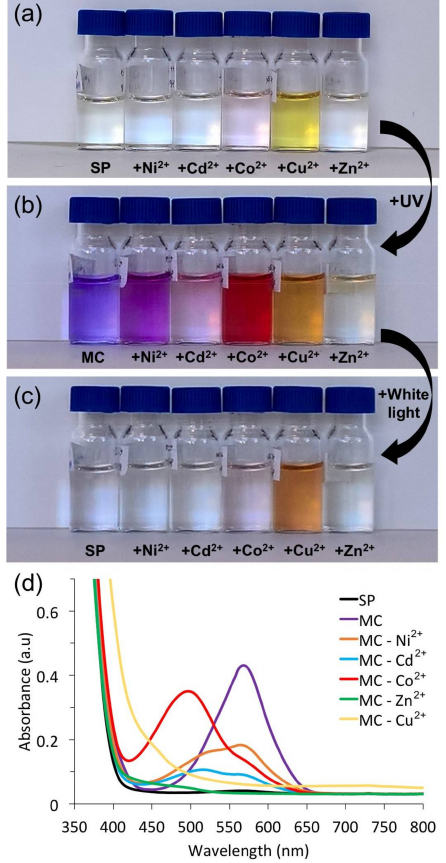
Figure 2. Images ( a – c ) and UV-Vis spectra ( d ) of the SP solutions in ACN (1.5 × 10 − 3 M) in the presence of various divalent metal ions (molar ratio SP:M 2+ 2:1); ( a ) initial solutions before illumination; ( b ) after 10 min of UV light illumination; ( c ) after 10 min of white light illumination; ( d ) UV-Vis spectra of solutions shown in ( b